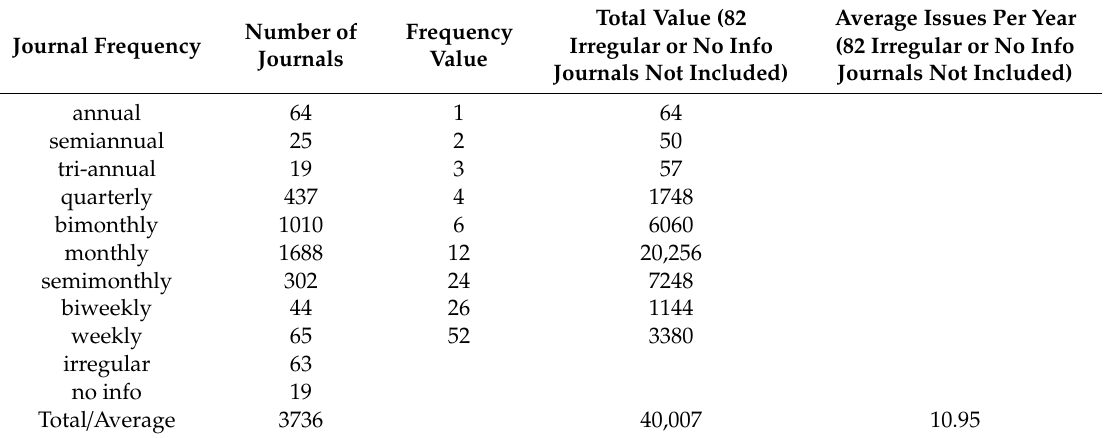
Table 1. Science Citation Index (SCI) journals’ frequency—all journals’ data.